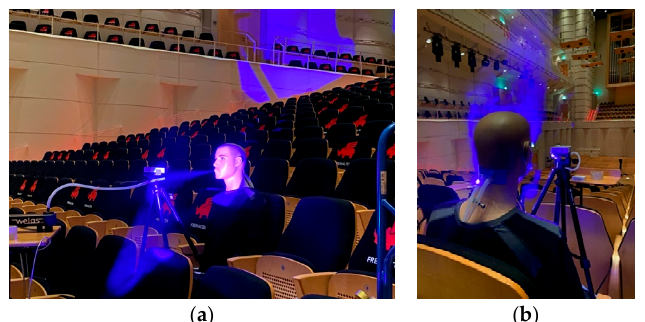
Figure 1. Experimental set-up of the dummy visualizing emitted aerosols by blue light illumination. ( a ) Dummy without a mask. ( b ) Dummy wearing a surgical mask.